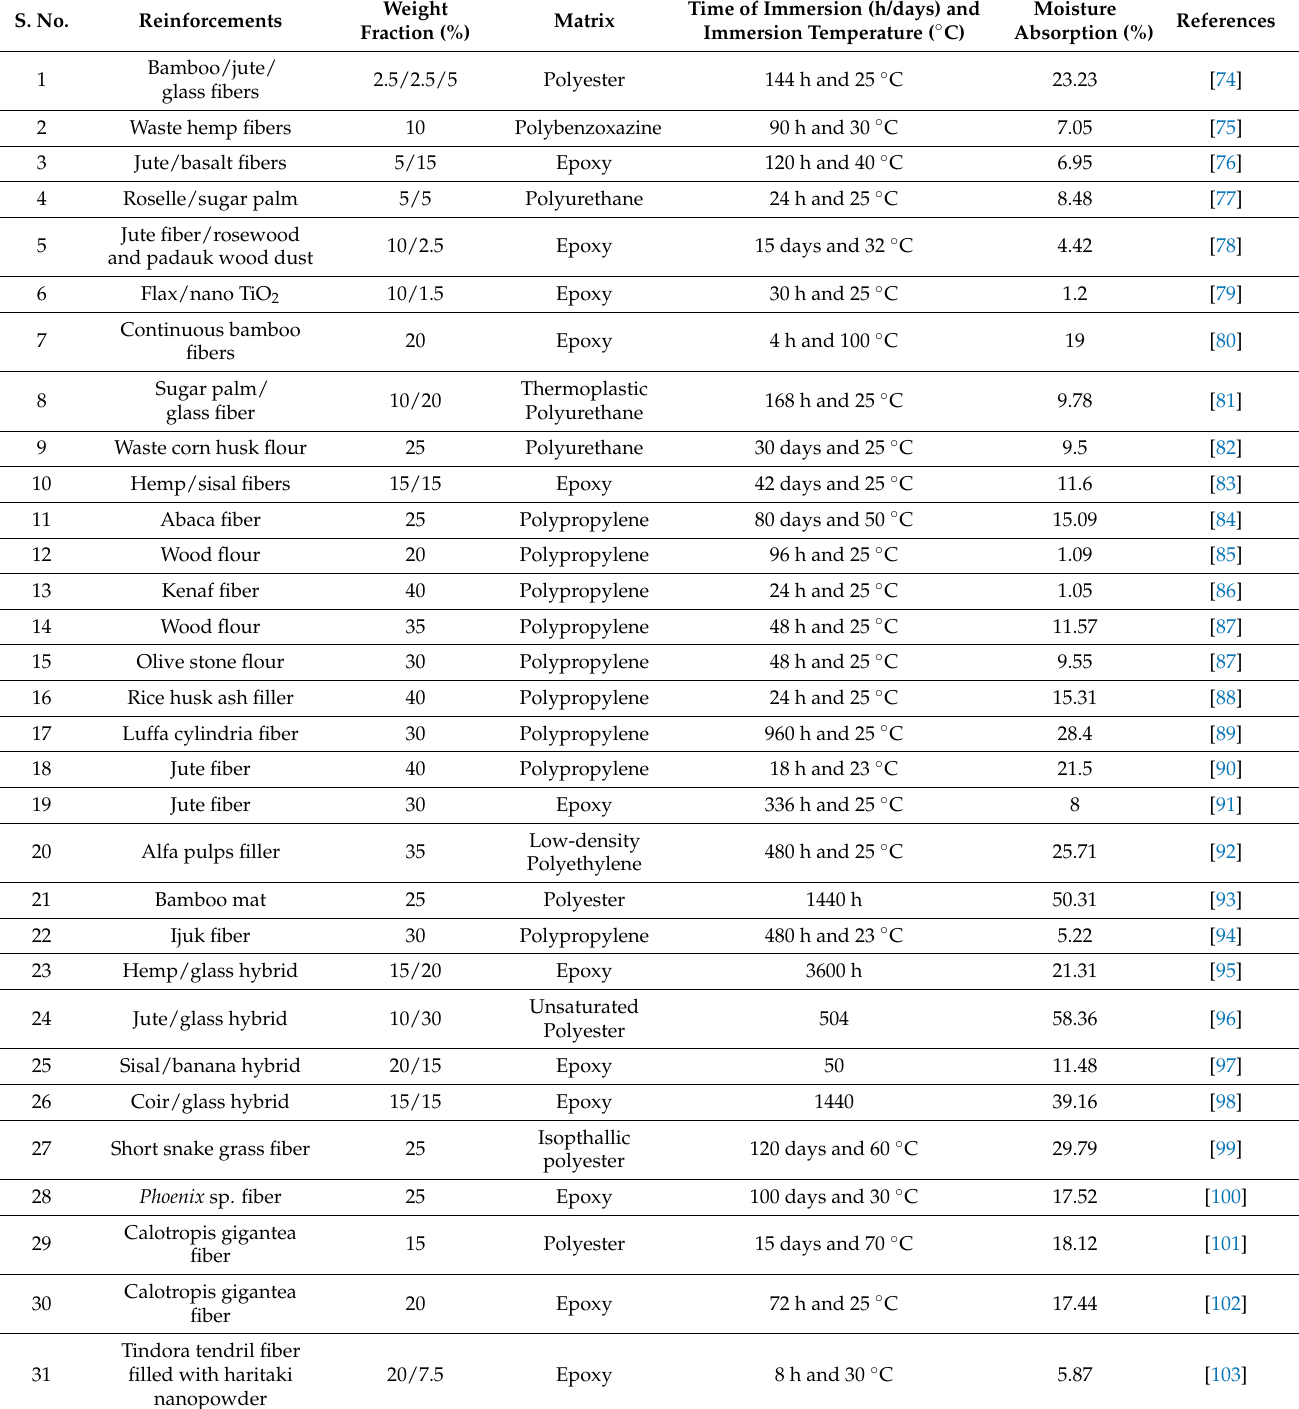
Table 1. Hygrothermal properties of natural fiber polymer